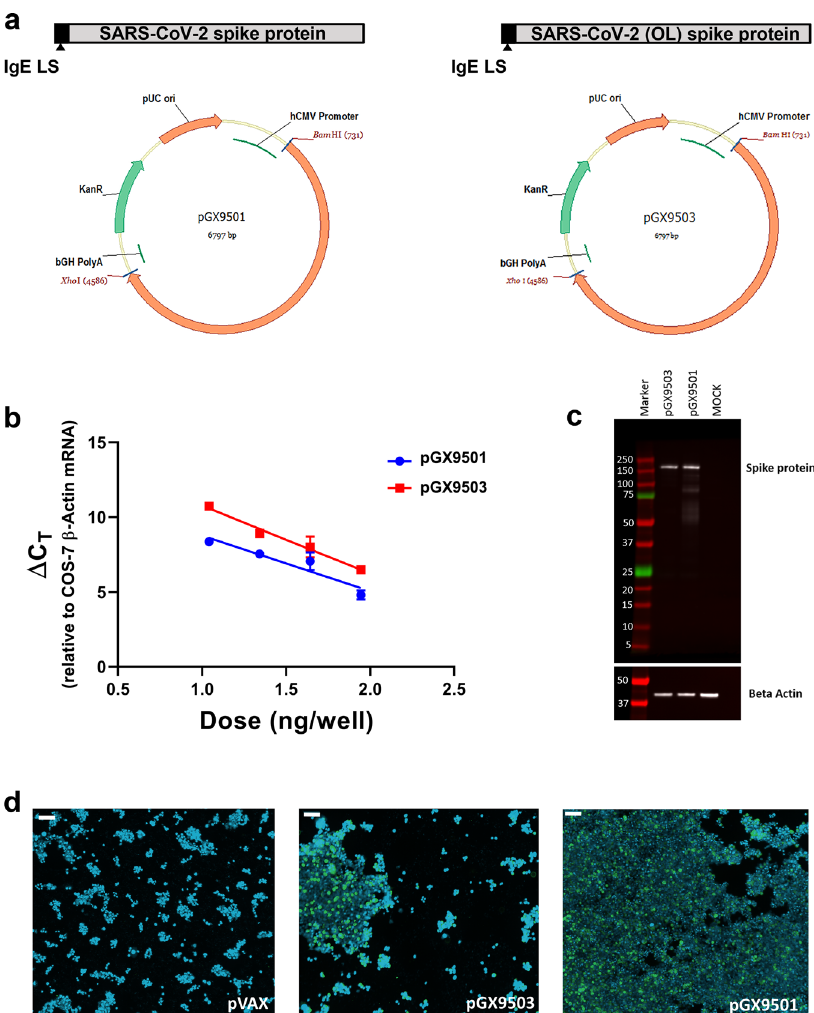
Fig. 2 Design and expression of COVID-19 synthetic DNA vaccine constructs. a Schematic diagram of COVID-19 synthetic DNA vaccine constructs, pGX9501 (matched) and pGX9503 (outlier (OL)) containing the IgE leader sequence and SARS-CoV-2 spike protein insert. b RT-PCR assay of RNA extracts from COS-7 cells transfected in duplicate with pGX9501 and pGX9503. Extracted RNA was analyzed by RT-PCR using PCR assays designed for each target and for COS-7 β -Actin mRNA, used as an internal expression normalization gene. Delta C T ( Δ C T ) was calculated as the C T of the target minus the C T of β -Actin for each transfection concentration and is plotted against the log of the mass of pDNA transfected (Plotted as mean ± SD). c Analysis of in vitro expression of Spike protein after transfection of 293T cells with pGX9501, pGX9503 or MOCK plasmid by Western blot. 293T cell lysates were resolved on a gel and probed with a polyclonal anti-SARS Spike Protein. Blots were stripped then probed with an anti- β -actin loading control. d In vitro immuno fl uorescent staining of 293T cells transfected with 3 µ g/well of pGX9501, pGX9503 or pVax (empty control vector). Expression of Spike protein was measured with polyclonal anti-SARS Spike Protein IgG and anti-IgG secondary (green). Cell nuclei were counterstained with DAPI (blue). Images were captured using ImageXpress Pico automated cell imaging system. Scale bars are 80.15 µ m (left), 66.8 µ m (middle) and 77.31 µ m